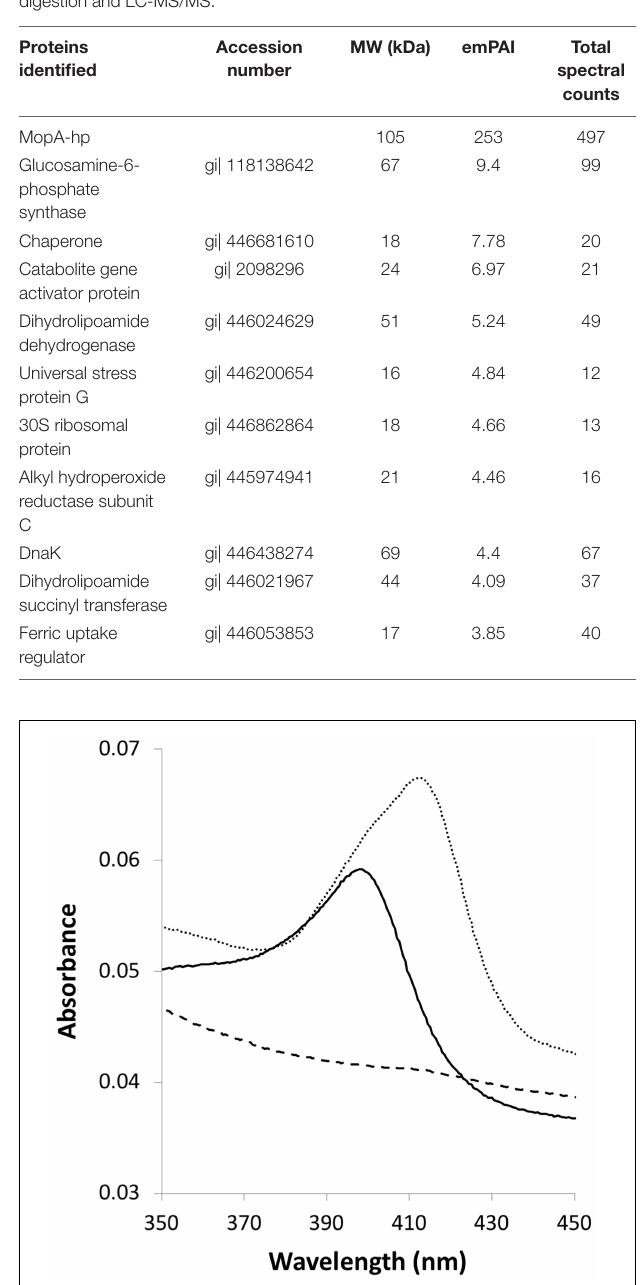
FIGURE 2 | Heme interaction with MopA-hp. A maximum absorbance shift (from 398 to 412.5 nm) within the Soret region results from protein–heme binding. Dashed line: 3 µ M NAC purified MopA-hp; solid line: 0.3 µ M heme: dotted line: 3 µ M NAC purified MopA-hp with the addition of 0.3 µ M